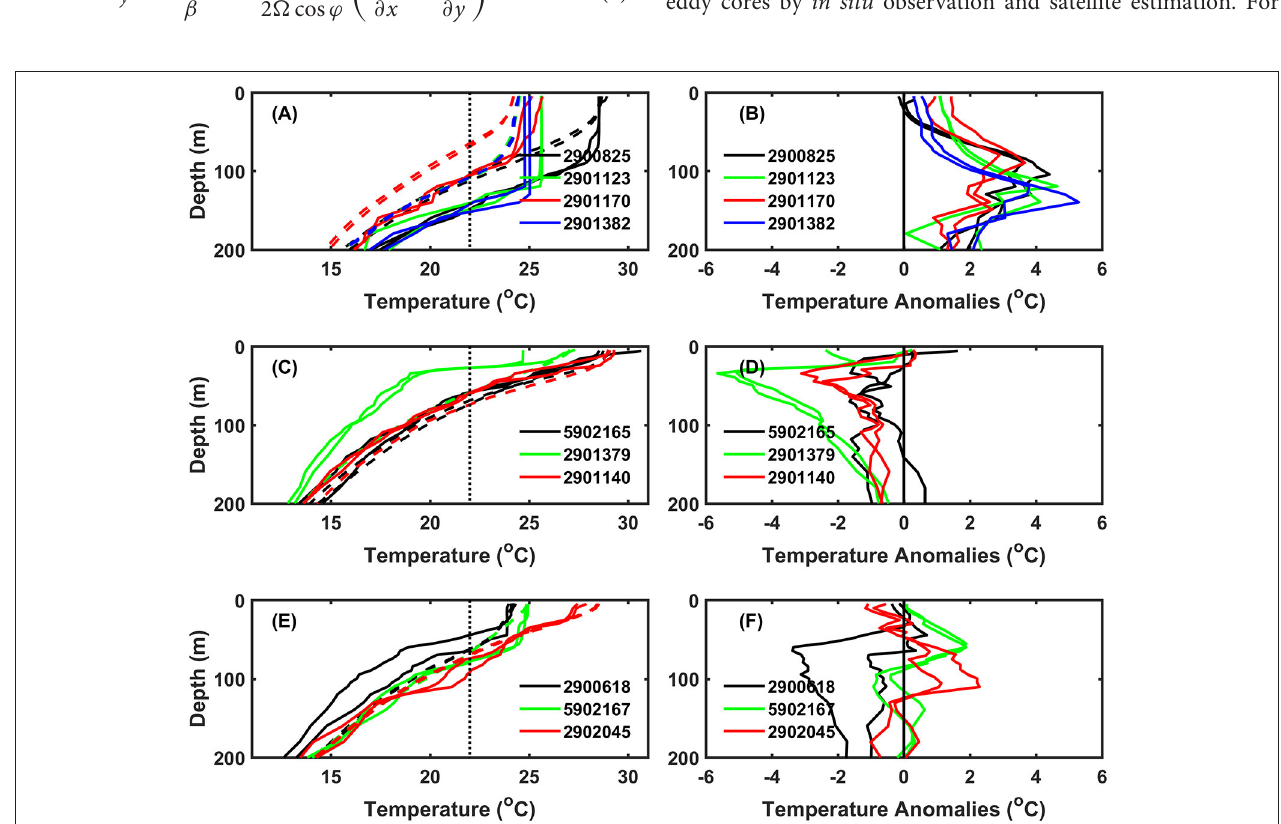
FIGURE 4 | Profiles of temperature (left) and temperature anomalies (right) observed via Argo floats near the eddy cores for the cases of (A,B) anticyclonic eddies with significant downwelling, (C,D) cyclonic eddies with significant upwelling, and (E,F) cyclonic eddies without significant upwelling. The dashed curves in the left panel show the climatological temperature profiles corresponding to the Argo profiles in the same month. The vertical dotted line in the left panel shows the temperature at 22 ◦ C.